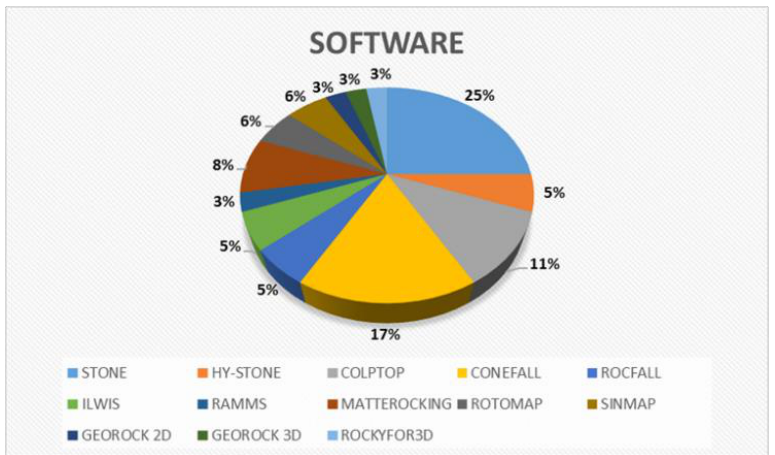
Figure 3. Pie chart illustrating the most and least frequently used software.